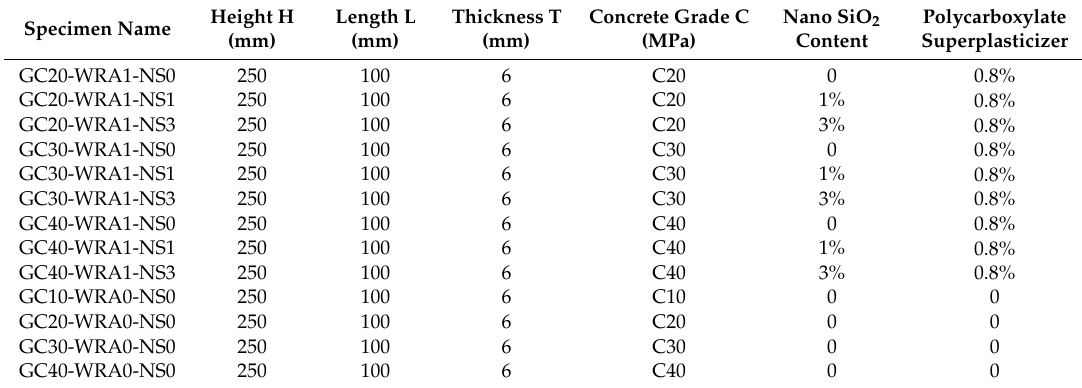
Table 1. Specimen number and specific parameters.